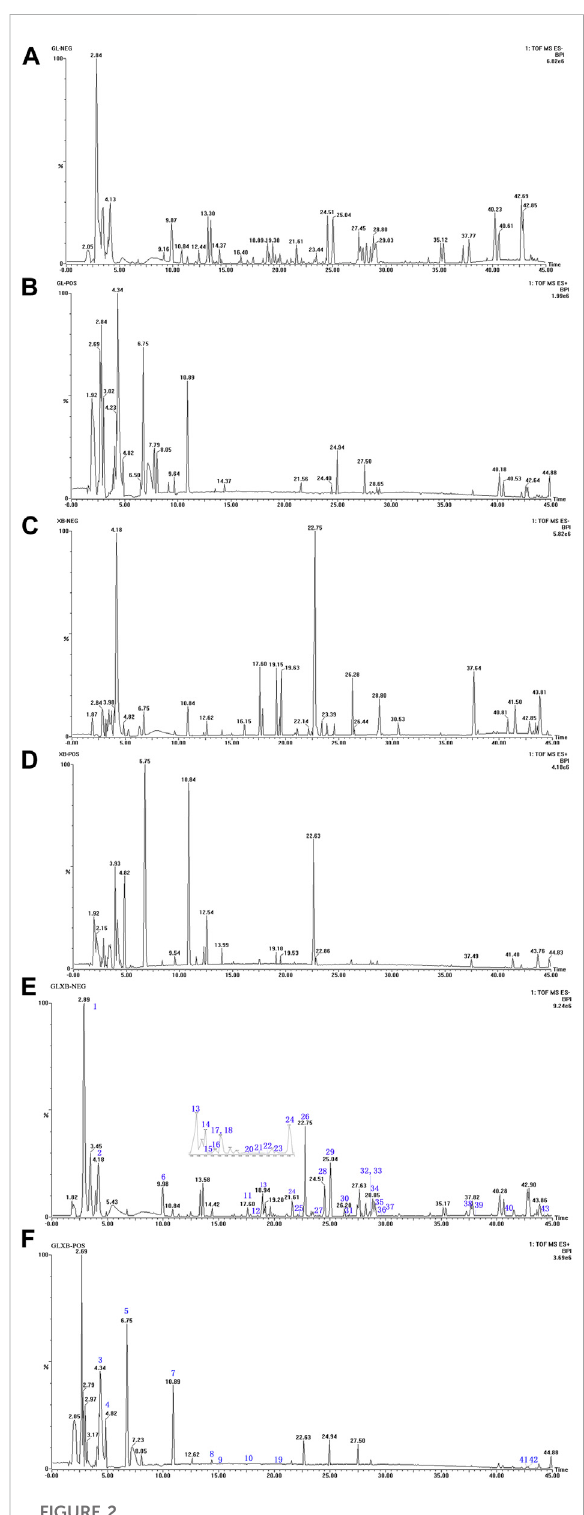
FIGURE 2 Thebasepeakintensity(BPI)chromatogramsofGLXBandsingleherbs from HPLC-Q-TOF-MS analysis. (A) Negative scan of Gualou; (B) positive scan of Gualou; (C) negative scan of Xiebai; (D) positive scan of Xiebai; (E) negative scan of Gualou – Xiebai; (F) positive scan of Gualou –